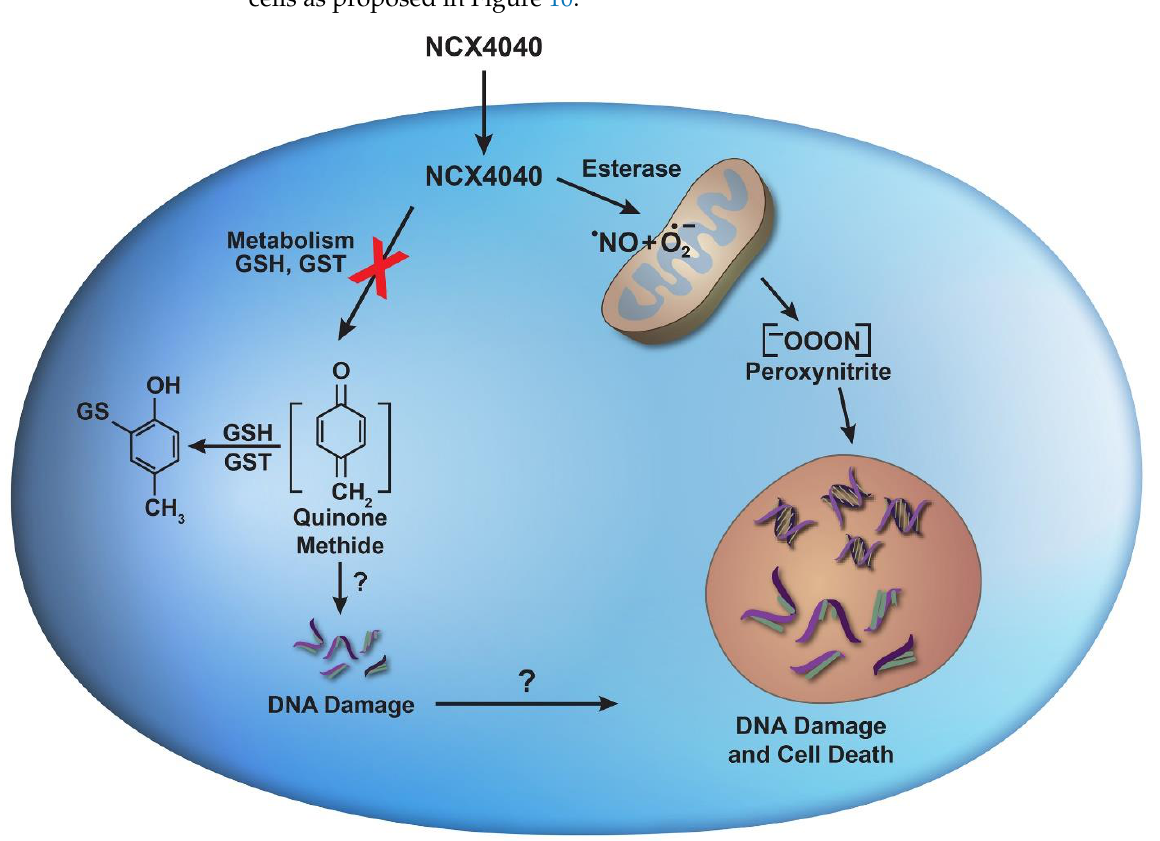
Figure 10. Proposed formation of reactive free radical species, • NO, O 2 •− , and O=N-O-O − following cellular metabolism of NCX4040 in tumor cells and role of peroxynitrite in tumor cell death.